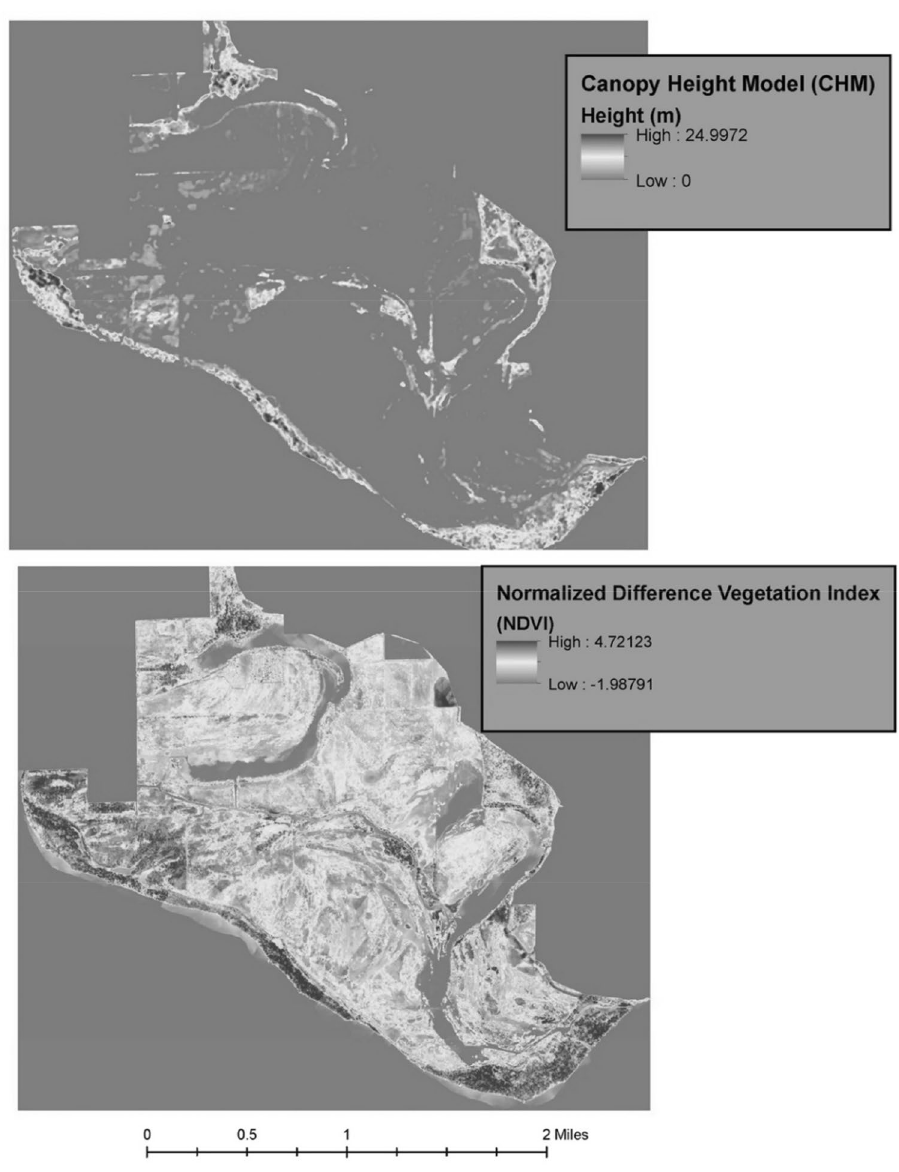
Figure 3. CHM and NDVI. LiDAR derived canopy height model (top) and normalized difference vegetation index derived from original spectral image. Software: ArcMap